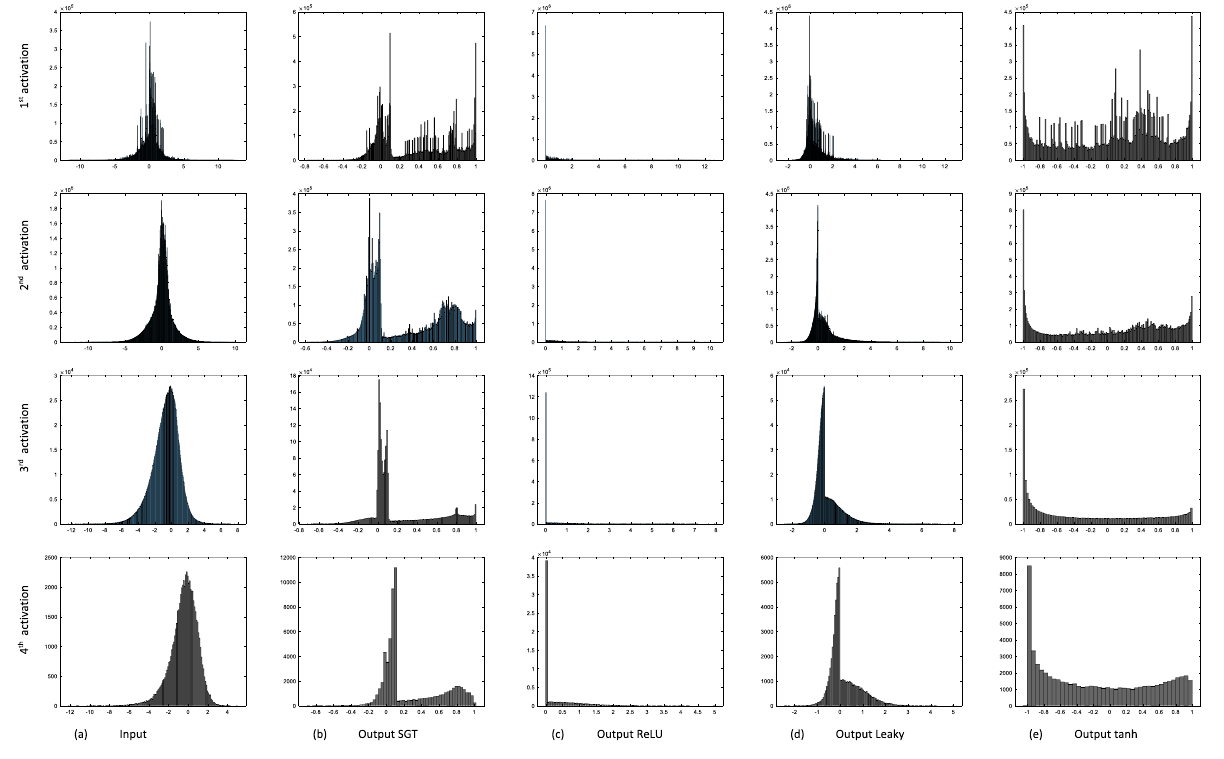
Figure 7. Histogram of the input features against output using various activation functions for a single MRI input plotted for different layers i.e., 4, 8, 12, and 16 (please see Table 2 for layers). Here, the histograms are combinedly produced using all the data values from 64 filters/channels. Generally, the combined histogram of all channels is similar to the single histogram of each channel (please see Fig. 7_app for comparing the histogram plot of 19th filter out of 64 filters for same input MRI in "Appendix" section).